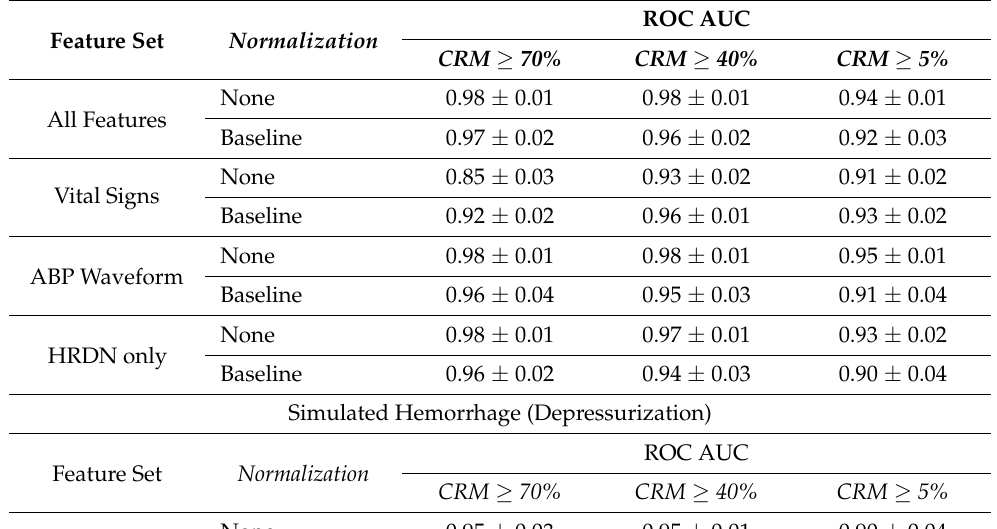
Table 4. Receiver Operating Characteristic Area Under Curve (ROC AUC) results for training and testing on the full data set (includes the baseline, depressurization, repressurization, and recovery phases from each experiment as shown in Figure 1) followed by training and testing on just the depressurization and repressurization